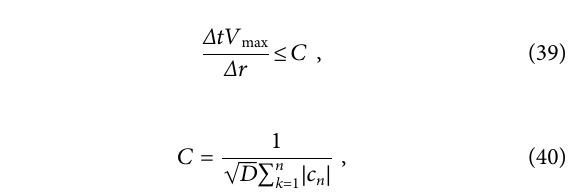
FIGURE 8 | Schematic diagram of the deformation progression for pure (A) and simple (B) shear deformations.